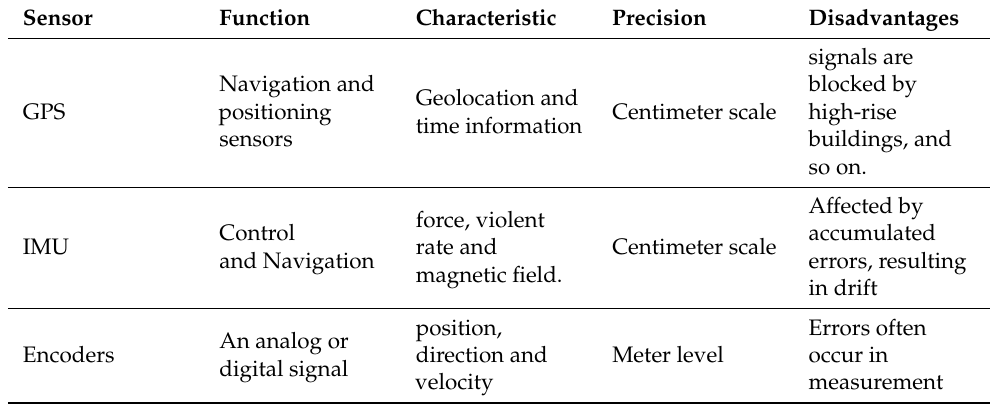
Table 2. Sensor characteristics of vehicle